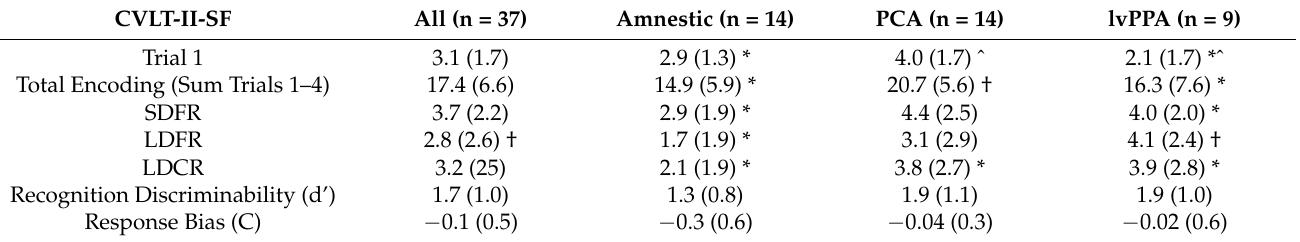
Table 2. CVLT-II-SF Performance. Mean (SD) of raw scores presented for each